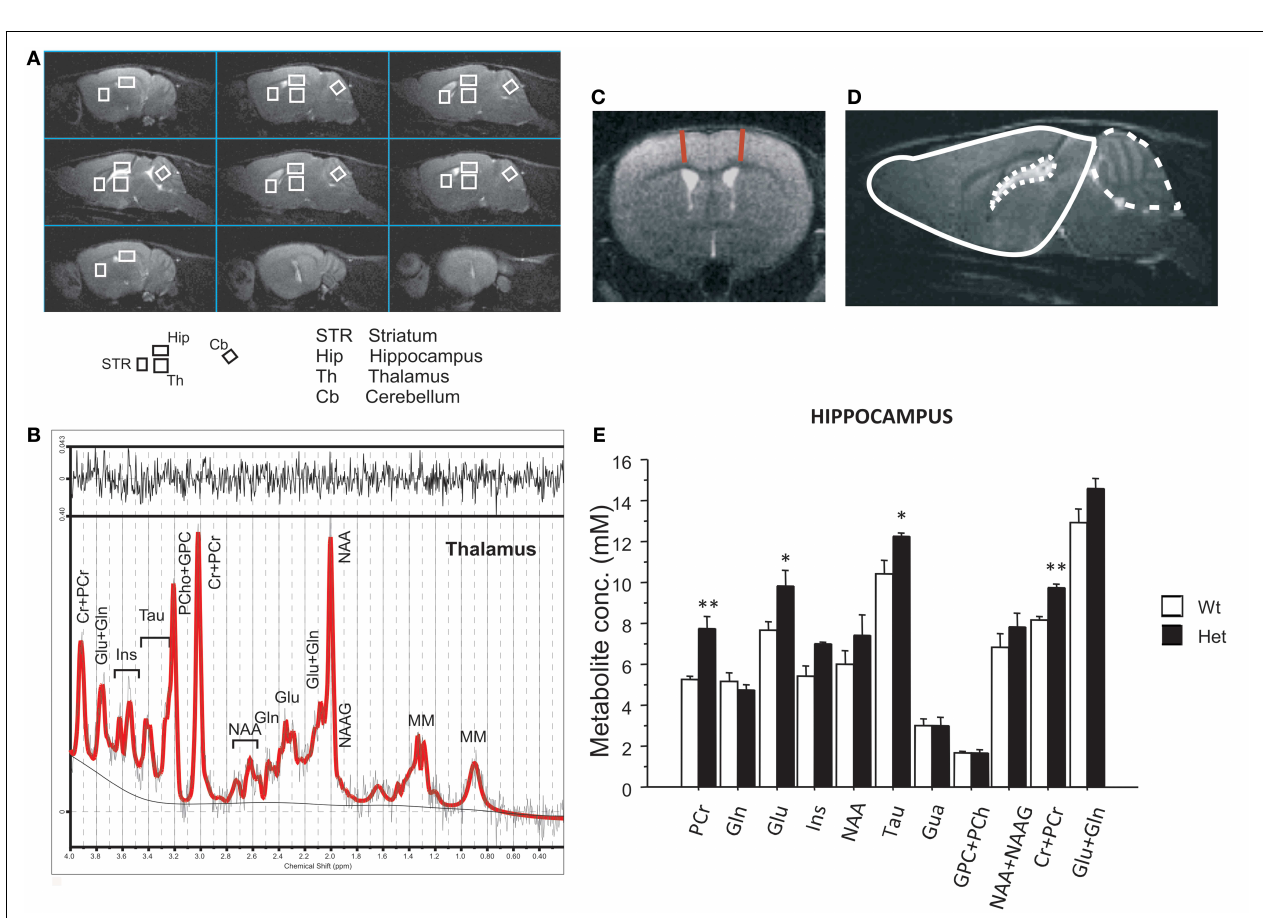
N -acetyl-aspartyl-glutamate; MM, macromolecules. (C) Examples of axial fastT2-weighted MR images from reeler heterozygous (Het) mice, respectively (TR/TEeff = 3200/60ms, ns = 4, slice thickness 0.6mm, 24 slices, matrix 256 × 256, FOV = 25mm × 25mm, which correspond to voxel resolution of 98 × 98 × 600 µ m 3 ).The red lines show the motor cortex thickness measure. (D) Example of brain segmentation for volumetric analyses of brain (plain line), cerebellum (dashed line), and ventricles (dotted line). (E) The histogram shows metabolite concentrations in hippocampus (Hip) for the two groups. Data are expressed as mean + SEM, * P < 0.05, ** P < 0.005 between wildtype and heterozygous reeler mice. N = 7Wt and N = 7